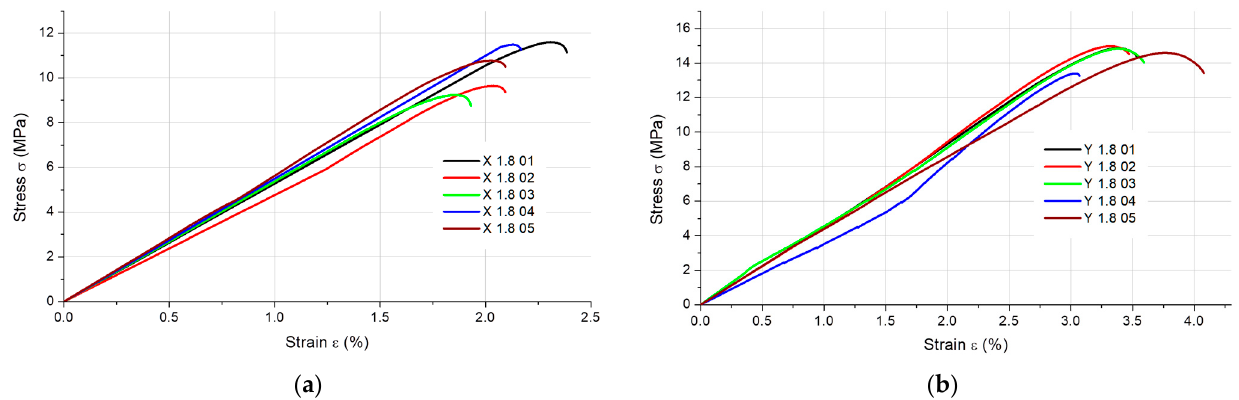
Figure 4. Stress–strain curves for the 1.8 mm thick specimens composed of PLA + bronze printed in ( a ) the X orientation and ( b ) the Y orientation.